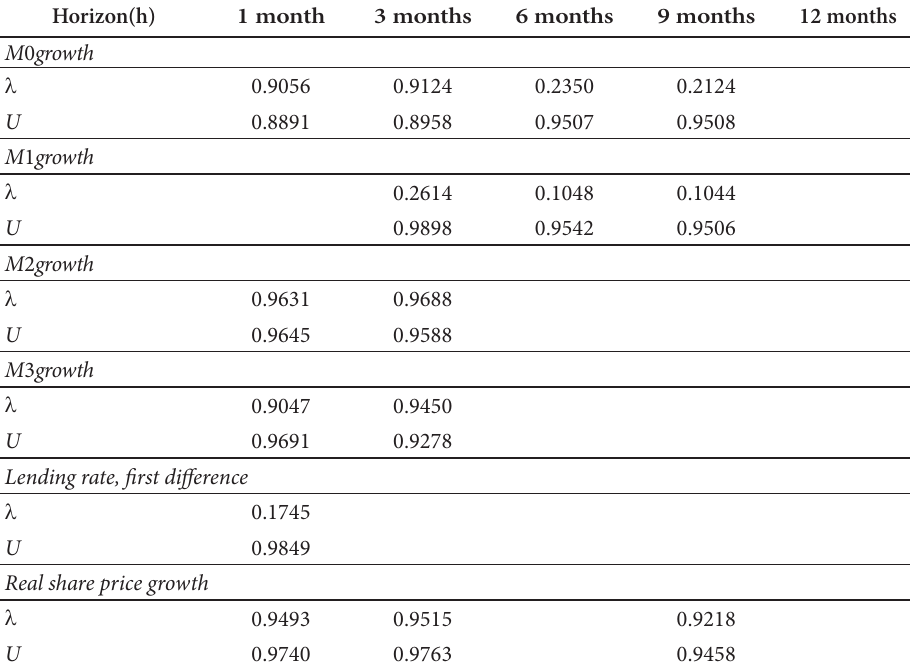
Table 2. Least squares estimations of